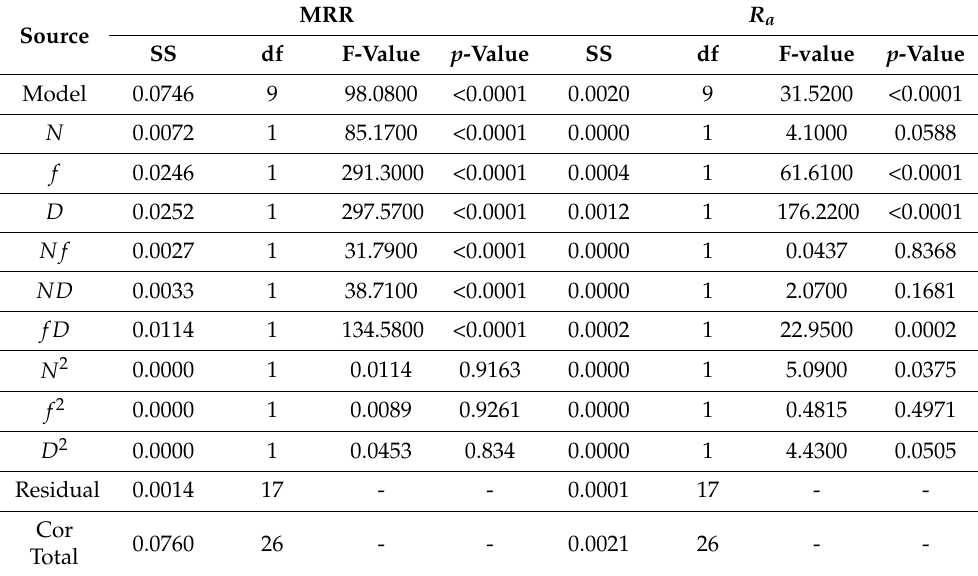
Table 1. ANOVA for the full quadratic mathematical models.